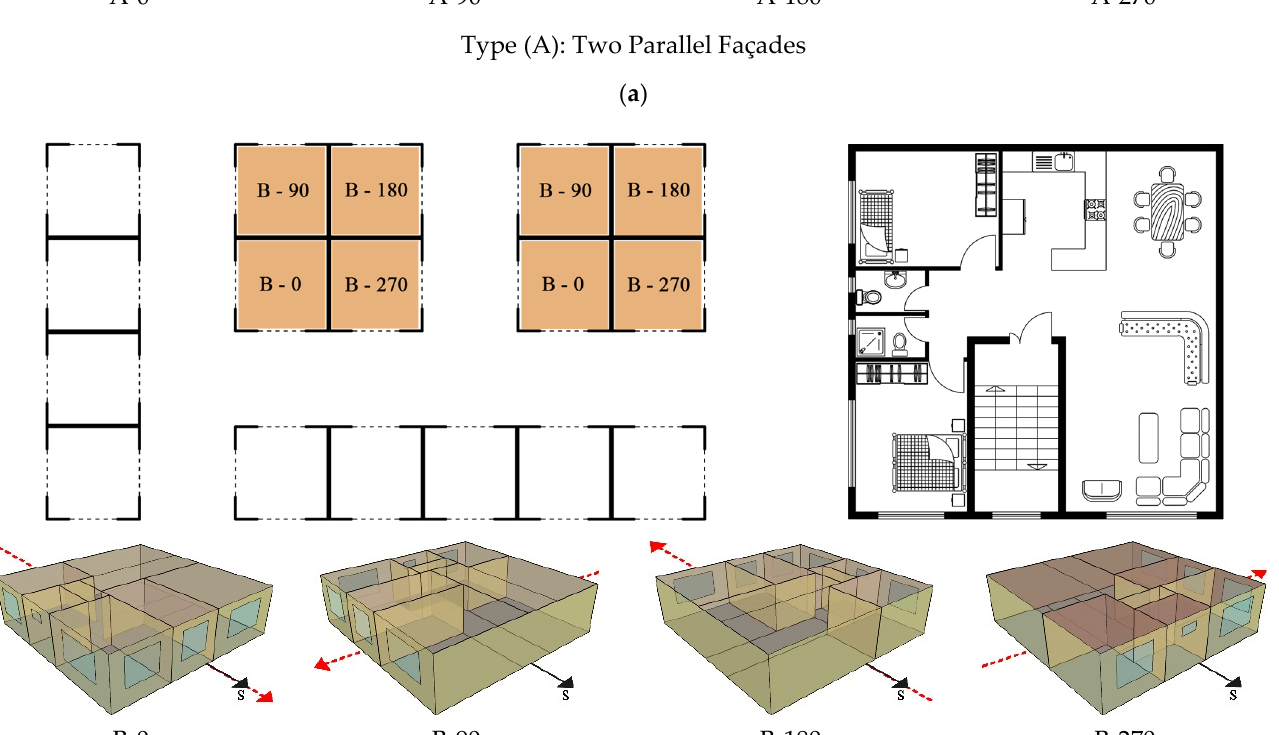
C-270 Type (C): Three Façades ( c ) Figure 4. Classification of the considered alternatives: ( a ) type (A) with two parallel façades; ( b ) type (B) with two perpen- dicular façades; ( c ) type (C) with three façades. 3.4. Definition of the Considered Objectives In order to find the winning alternative, the effect of the decision criteria on energy consumption, environmental impact, thermal comfort, and visual performance is taken into account. These four aspects are defined by some indicators considered as the objective functions, which are described in the following.